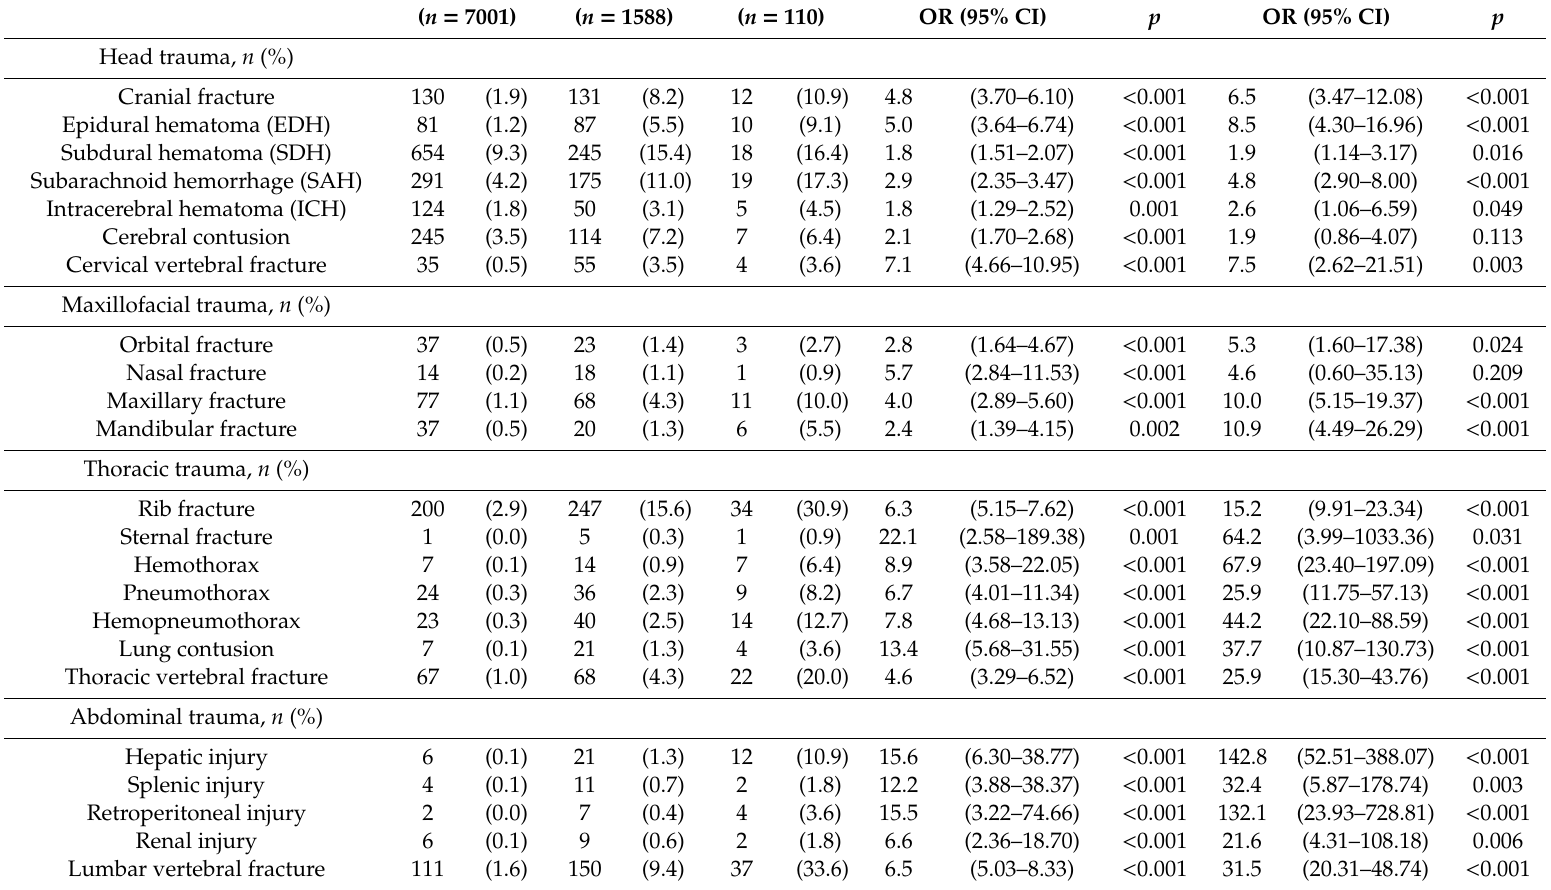
Table 4. Associated injuries in body regions of patients after falls from di ff erent